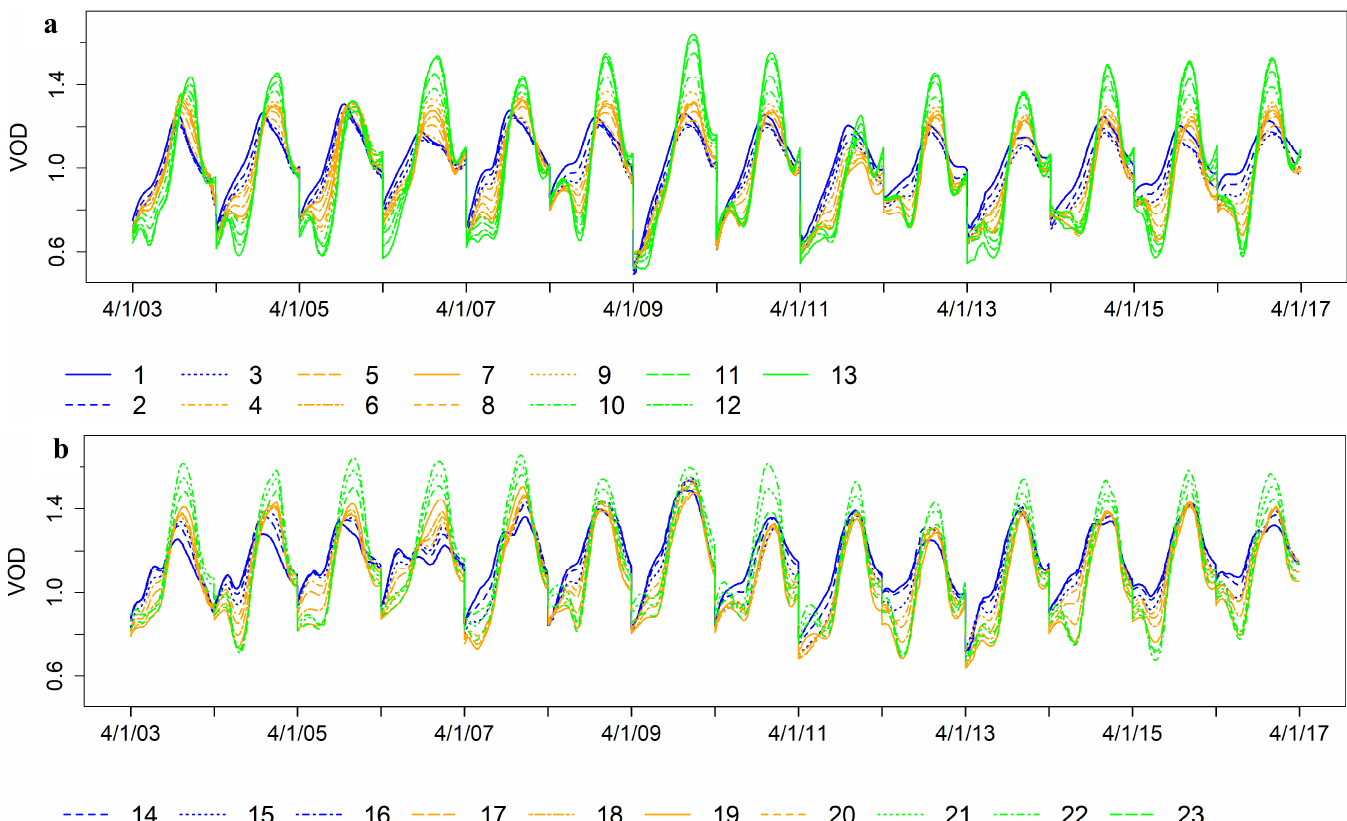
Figure 6. Vegetation optical depth (VOD) time series plots for the AMSR pixel sites of study area transects in: ( a ) east-central North Dakota, and ( b ) eastern South Dakota for 2003 / 06–2016 with DOY 91-305 annual cycles. Lines in the figure were grouped in to three: (1) grass dominated most western study sites with smaller amplitude (blue, 1–3 in ND and 14–16 in SD); (2) mixed grassland / pasture and crop cover middle sites (golden, 4–9 in ND and 17–20 in SD); and (3) crop cover dominated most eastern sites that have larger amplitude (green, 10–13 in ND and 21–23 in SD).